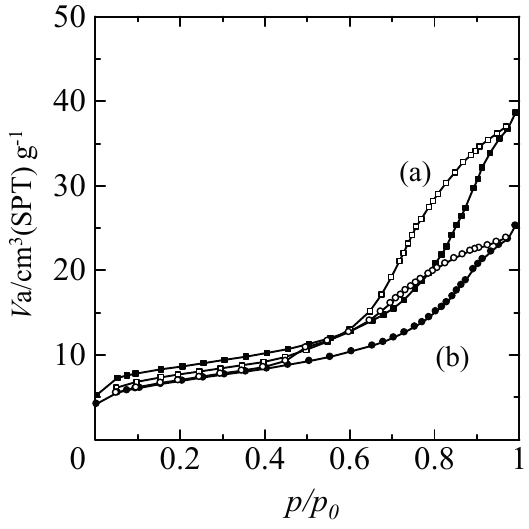
Figure 5. Adsorption and desorption isotherms of the zeolite-porous glass composite- (a) before and (b) after TiO 2